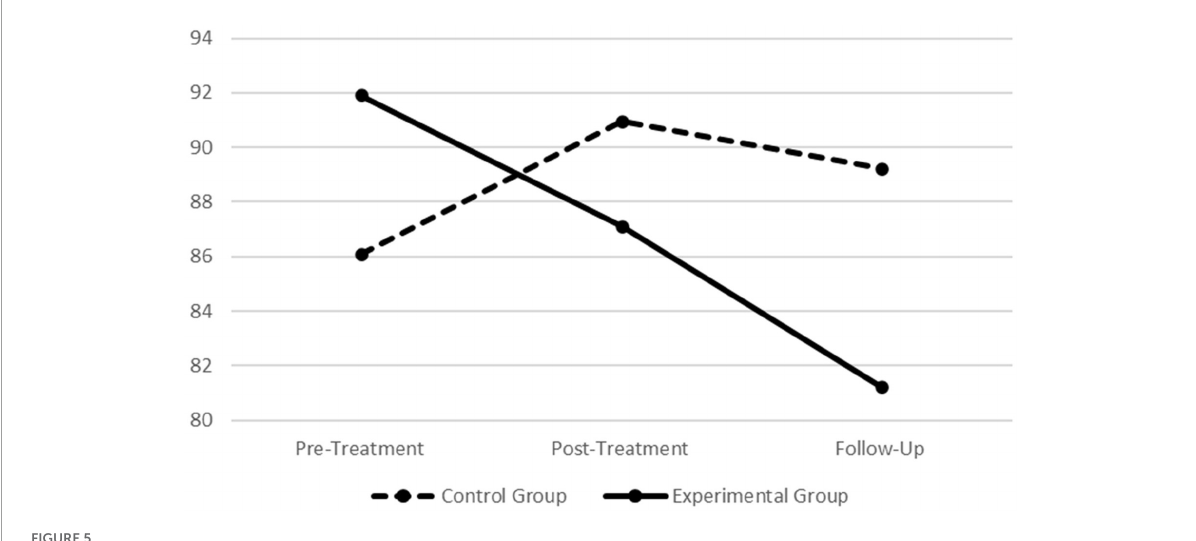
FIGURE5 Graphic presentation of group differences in the Difficulties in Emotion Regulation Scale–Adolescent Version (DERS-AV) total score across the pre-treatment, post-treatment, and follow-up assessment periods.